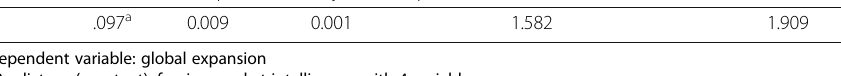
Table 13 Model summary — coefficient of determination ( R 2 ) Model R R square Adjusted R square Std. error of the estimate Durbin-Watson